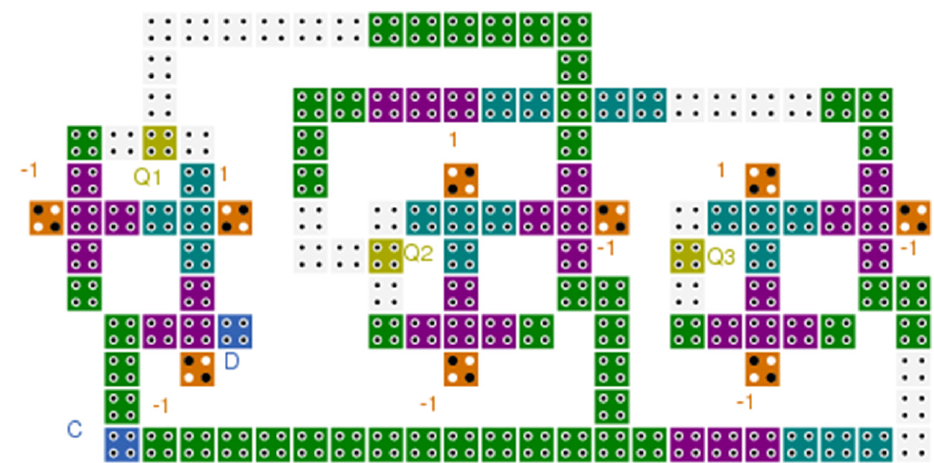
Figure 18. QCA Implementation of 3-bit SIPO shift register.